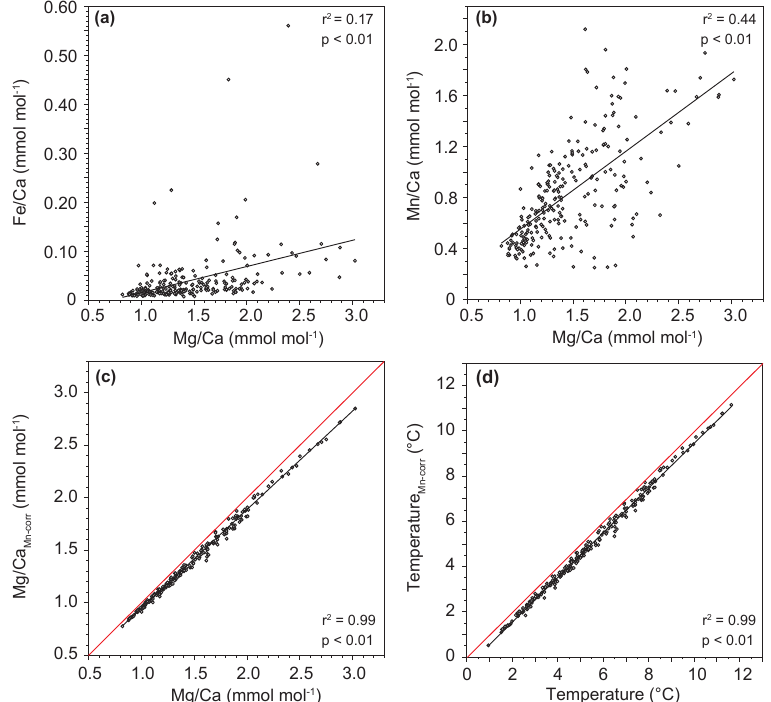
Figure 4. Evaluation of the potential contamination of Mg / Ca ratios in G. crassaformis . (a) Scatter plot of measured Mg / Ca and Fe / Ca ratios. (b) Scatter plot of measured Mg / Ca and Mn / Ca ratios. (c) Scatter plot of measured Mg / Ca and Mg / Ca ratios corrected for Mn- bearing overgrowths (using the assumption of an unrealistically high Mg / Mn ratio of 1) in comparison to uncontaminated samples (red line). (d) Scatter plot of temperatures calculated from measured Mg / Ca and Mg / Ca ratios corrected for Mn-bearing overgrowths (using the assumption of an unrealistically high Mg / Mn ratio of 1) in comparison to uncontaminated samples (red line) (see Sect. 5.2 for